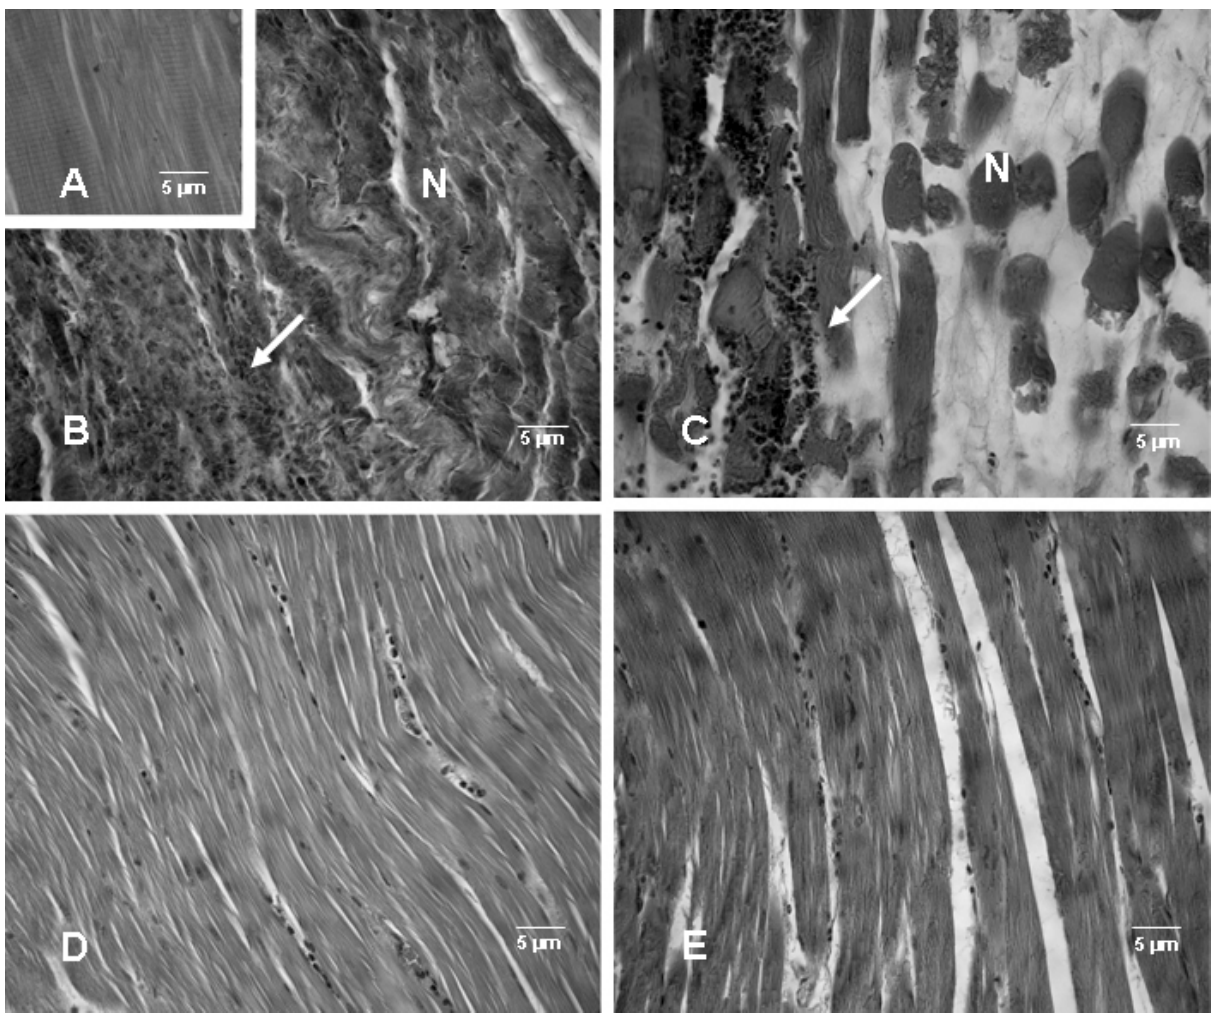
Figure 4. Light micrographs of sections of mouse gastrocnemius muscle 24 hours after intramuscular inoculation of BthTX-I or BthTX-II. ( A ) Control gastrocnemius muscle injected with a saline solution presents normal fibers; ( B ) BthTX-I and ( C ) BthTX-II inoculations show muscles with typical alterations due to myonecrosis (N) and infiltration of leukocytes (arrows). Alterations of the gastrocnemius muscle after inoculation of BthTX-I and BthTX-II with LLLT are shown in ( D ) and ( E ), respectively. It is observed that LLLT is effective in decreasing the number of destroyed fibers. Bar corresponds to 5 µm in all